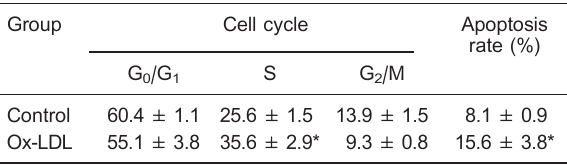
Table 2. Changes in the cell cycle and apoptosis rates after human umbilical vein endothelial cells were treated with 100 m g/ mL Ox-LDL for 24 h.